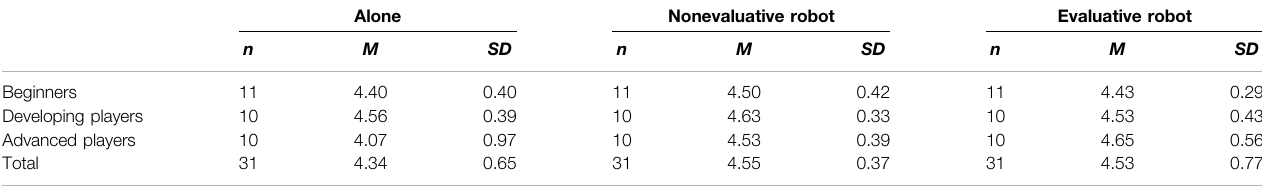
TABLE 4 | Mean and standard deviation of motivation collected by the questionnaire in the alone, nonevaluative robot, and evaluative robot conditions. Alone